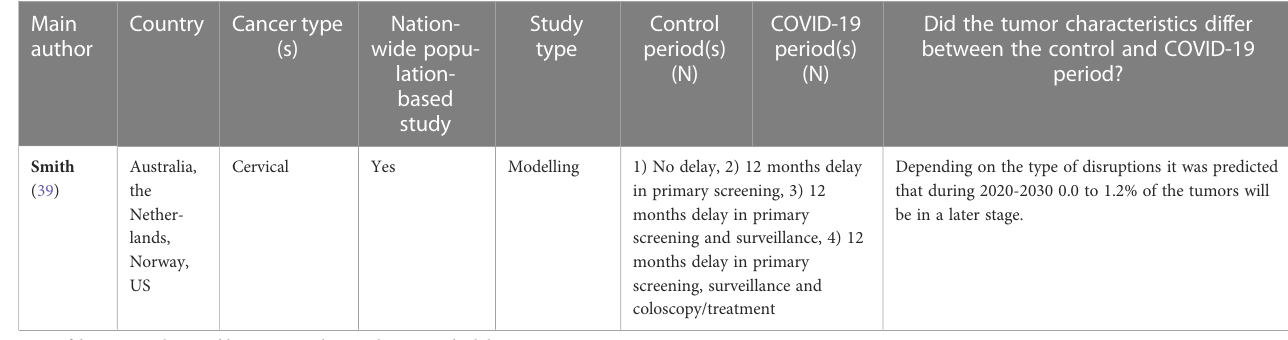
TABLE 2 Effect of the Covid-19 induced delays on survival according to modelling studies.